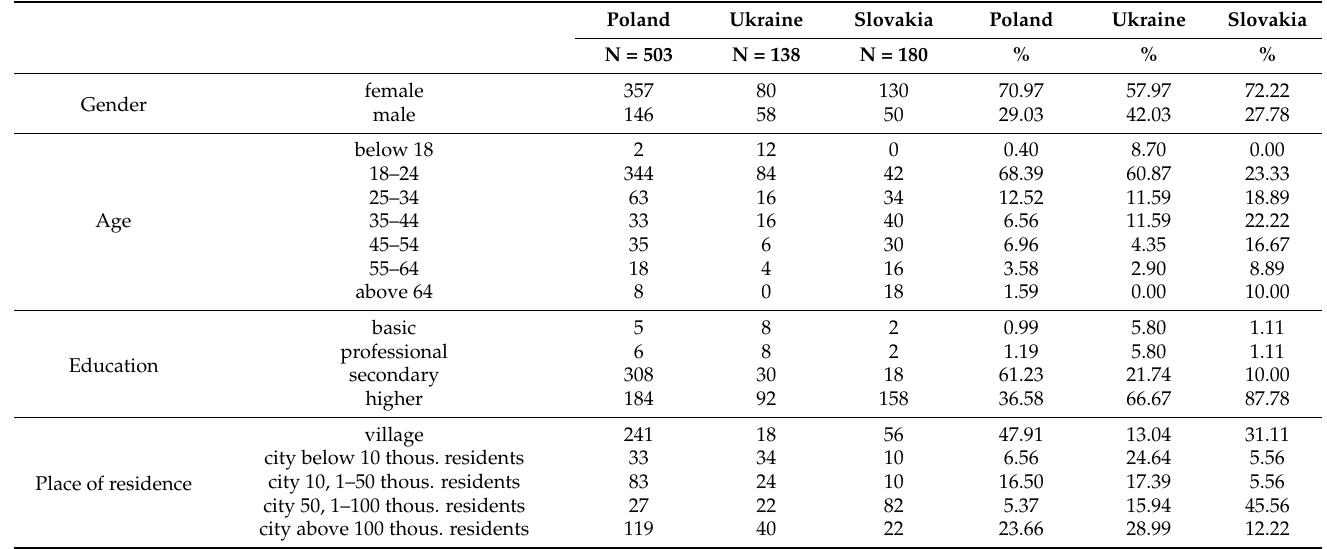
Table 1. Characteristics of